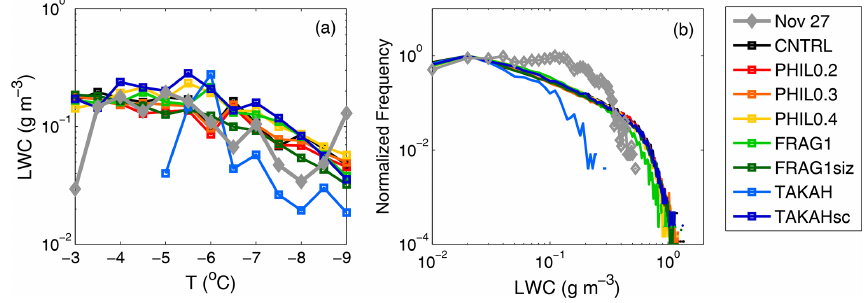
Figure 4. (a) Mean liquid water content (LWC) as a function of temperature for our case study (gray) and the eight model simulations. (b) Relative frequency distribution of LWC, binned in 0.01gm − 3 intervals, scaled with maximum frequency. Only values greater than 0.01gm − 3 within the lowest 1.5kma.s.l. are included in the analysis. Table 1. Mean modeled downward and upward shortwave (SWD SFC , SWU SFC ) and longwave (LWD SFC , LWU SFC ) surface radiation, along with upward shortwave and longwave (SWU TOA , LWU TOA ) radiation at the top of the atmosphere, during flights M218 and M219. Model results are averaged over the dashed rectangular area in Fig. 1. Simulation SWD SFC SWU SFC LWD SFC LWU SFC SWU TOA LWU TOA (Wm − 2